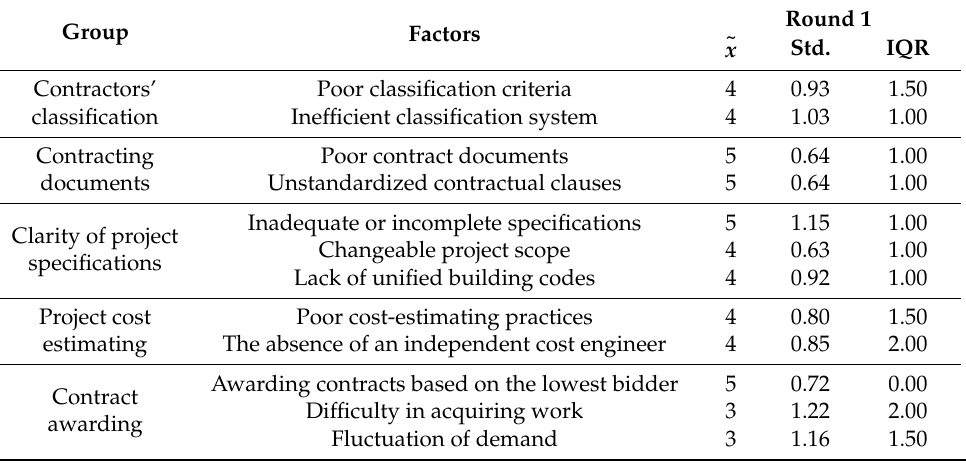
Table 1. Summary of the panel evaluation of the initial challenging factors in Round 1.